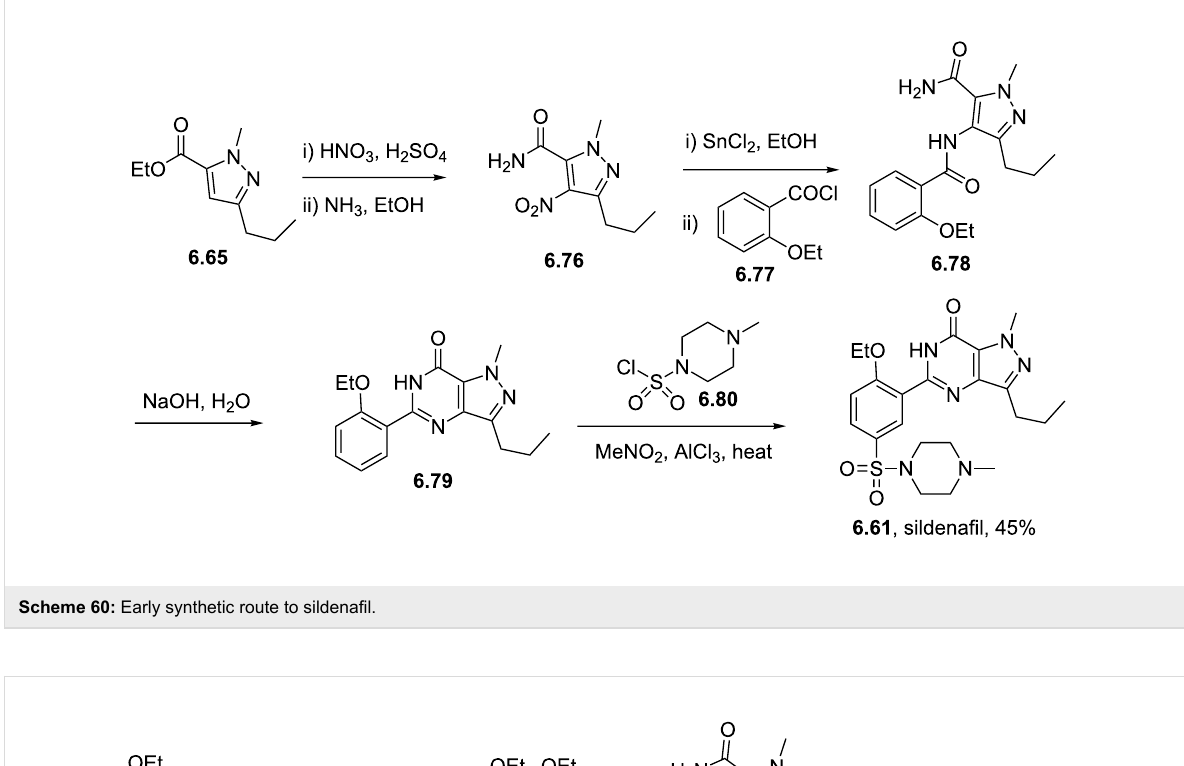
Scheme 60: Early synthetic route to sildenafil.